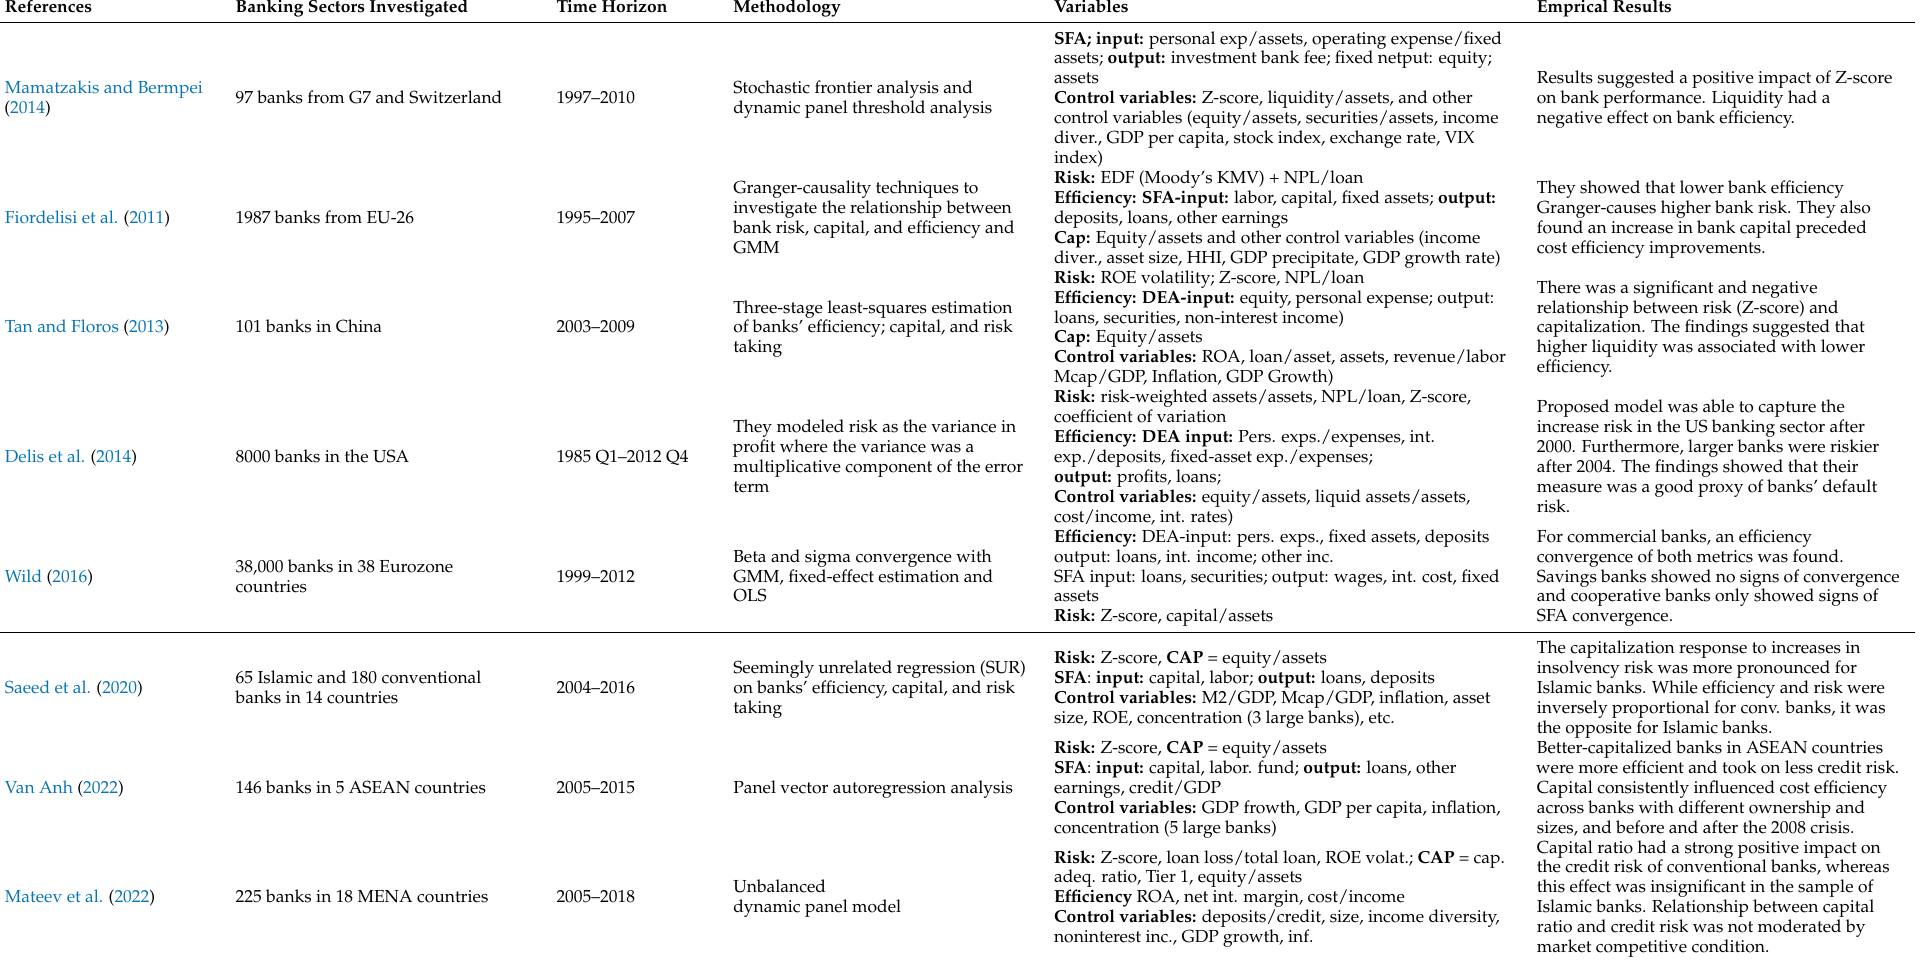
Table 2. Literature matrix for studies examining banks’ efficiency, risk, and